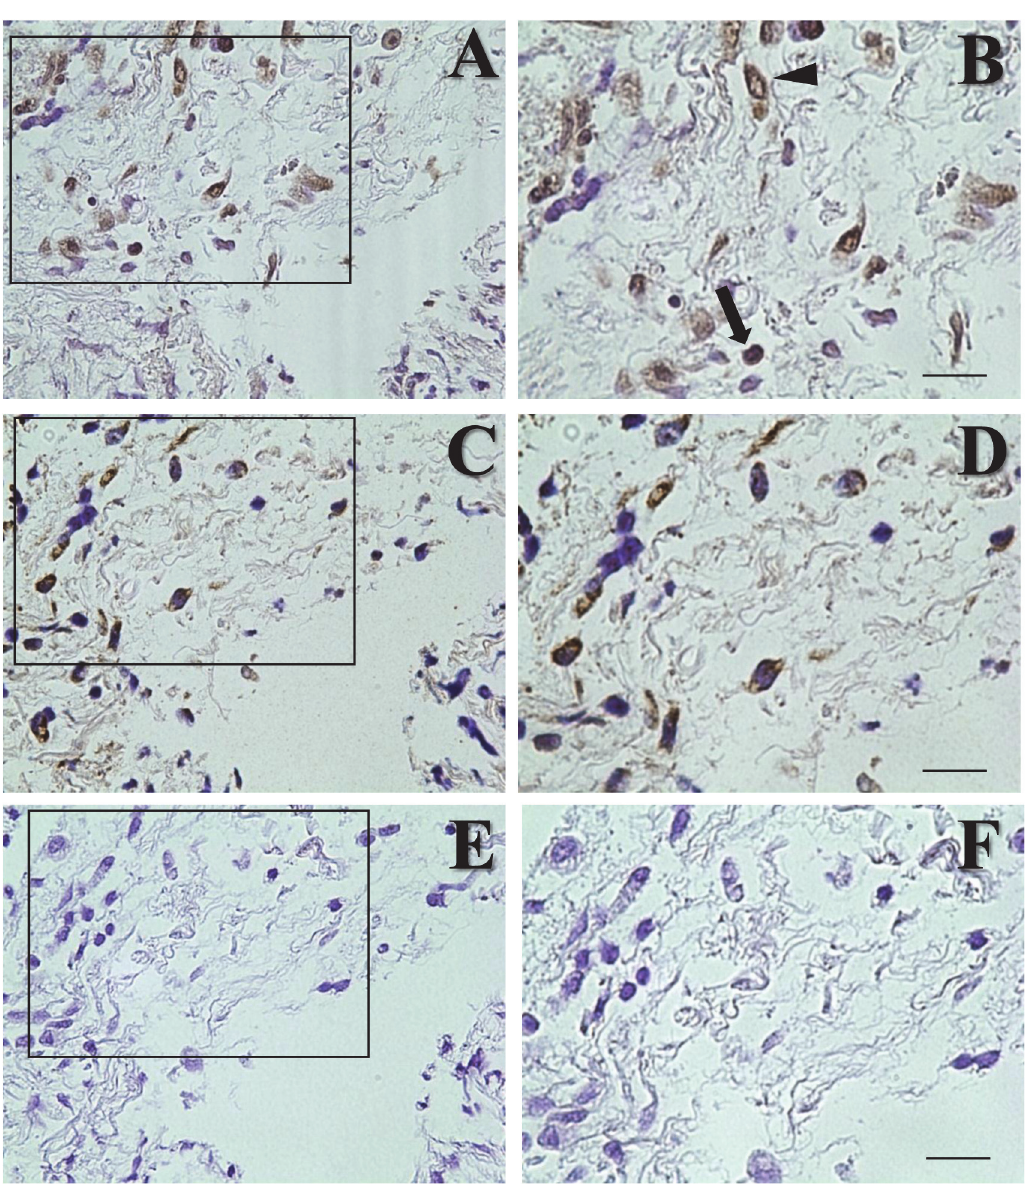
Fig 5. LMP-1 immunohistochemistry using serial sections of periapical granulomas. Framed boxes in left panels (A, C, E) were magnified to right panels (B, D, F, respectively). (A, B) LMP-1 immunohistochemistry showed positive staining in B cells (arrows) and plasma cells (arrow heads). (C, D) EBER- expressing cells were present at the same area of LMP-1-expressing cells. (E, F) A negative control using normal mouse IgG antibody did not exhibit LMP-1 expression. Scale bar = 50 μ